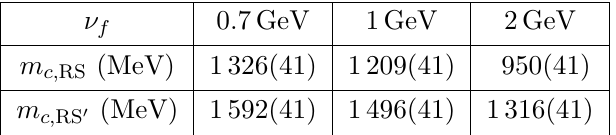
Table 2 . RS and RS’ charm quark masses for di(cid:11)erent values of (cid:23) f